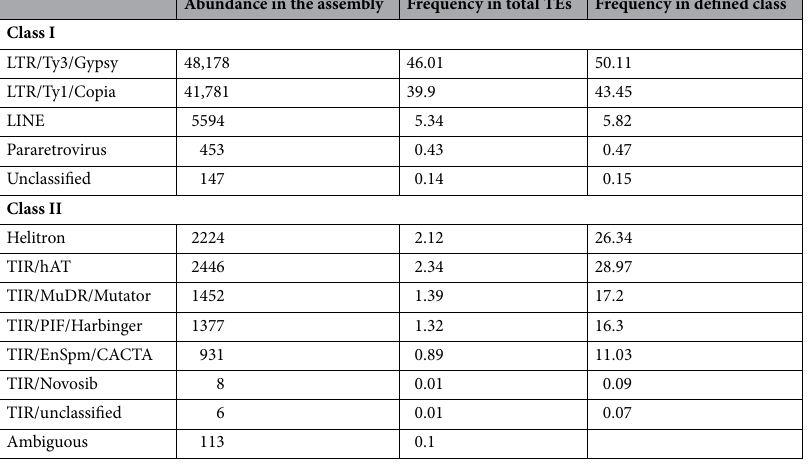
Table 3. TE composition in C. oblonga genome